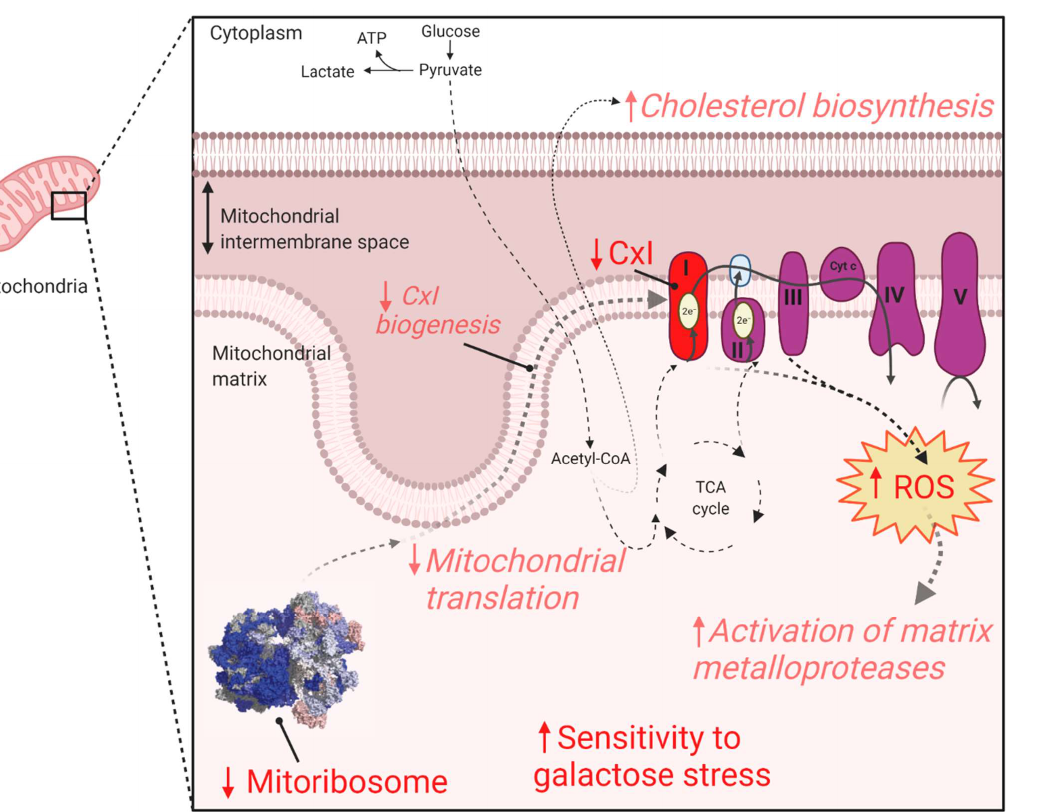
Figure 7. Schematic of mitochondrial dysfunction in patient fibroblasts . Quantitative proteomics (see Figure 4) demonstrated decreased levels of several protein subunits of both the large and small subunits of the mitoribosome and complex I (CxI), shown in red. The GO terms enriched in proteins at lower levels in the patient fibroblasts (see Supplemental Table S4) included complex I biogenesis and mitochondrial translation. The GO terms enriched in proteins at higher levels in patient fibro- blasts (see Supplemental Table S5) included the activation of matrix metalloproteases and choles- terol biosynthesis. All GO terms are in red italics. Patient fibroblasts were more sensitive to galactose stress and had elevated mitochondrial ROS. Figure created with BioRender.com (accessed on 12 January 2022). 4. Materials and Methods 4.1. Ethics All procedures followed were in accordance with the ethical standards and approved by the Human Research Ethics Committee of the Royal Children’s Hospital (HREC/67401/RCHM-2020 and HREC/16/MH251), and in were accordance with the Hel- sinki Declaration of 1975, as revised in 2000. Written informed consent was obtained from the parents individually and on behalf of their child. 4.2. MRI MRI was performed on a Siemens 3 Tesla system (Magnetom Prisma) and included 2D T2-weighted sequences in standard 3 orthogonal planes (TR = 6940 ms; TE = 170 ms; FA = 120 degrees; in-plane voxel resolution 0.63 mm; slice thickness 2.88 mm); diffusion- weighted imaging (the readout-segment echo-planar imaging (RESOLVE) sequence, 3 b =